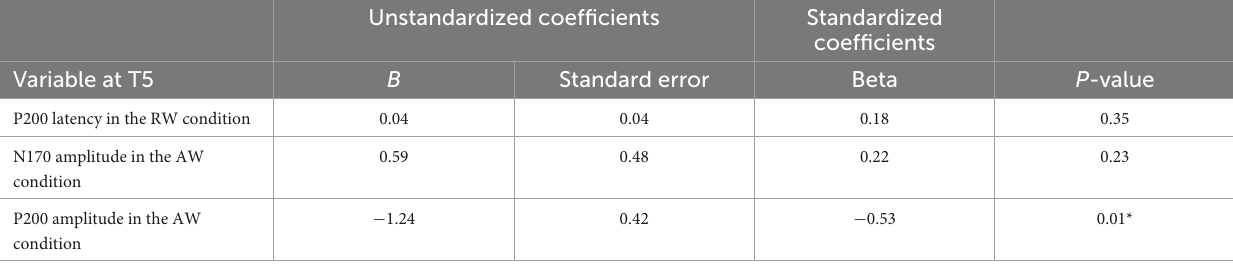
TABLE 1 Multiple regression analysis table of the model with the smallest CVE at the T5